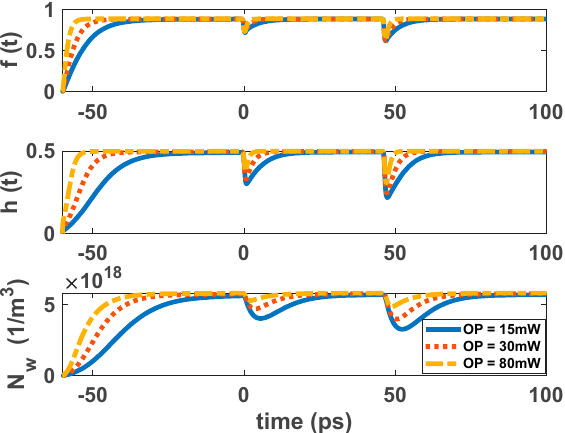
Figure 6. Occupation probability in the GS, ES, and electron concentration in WL as a function of time for different pump powers. Input signal power is 100 mW.